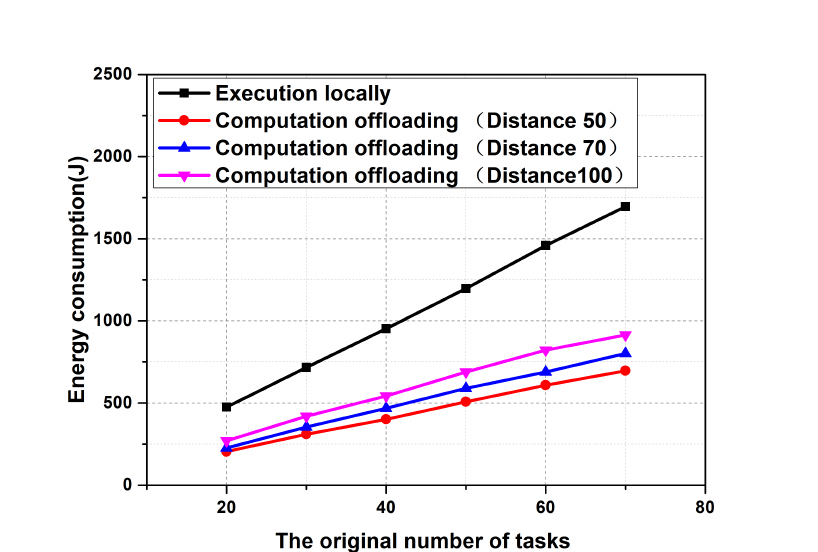
Figure 4. The energy consumption of the mobile device under a different number of tasks.